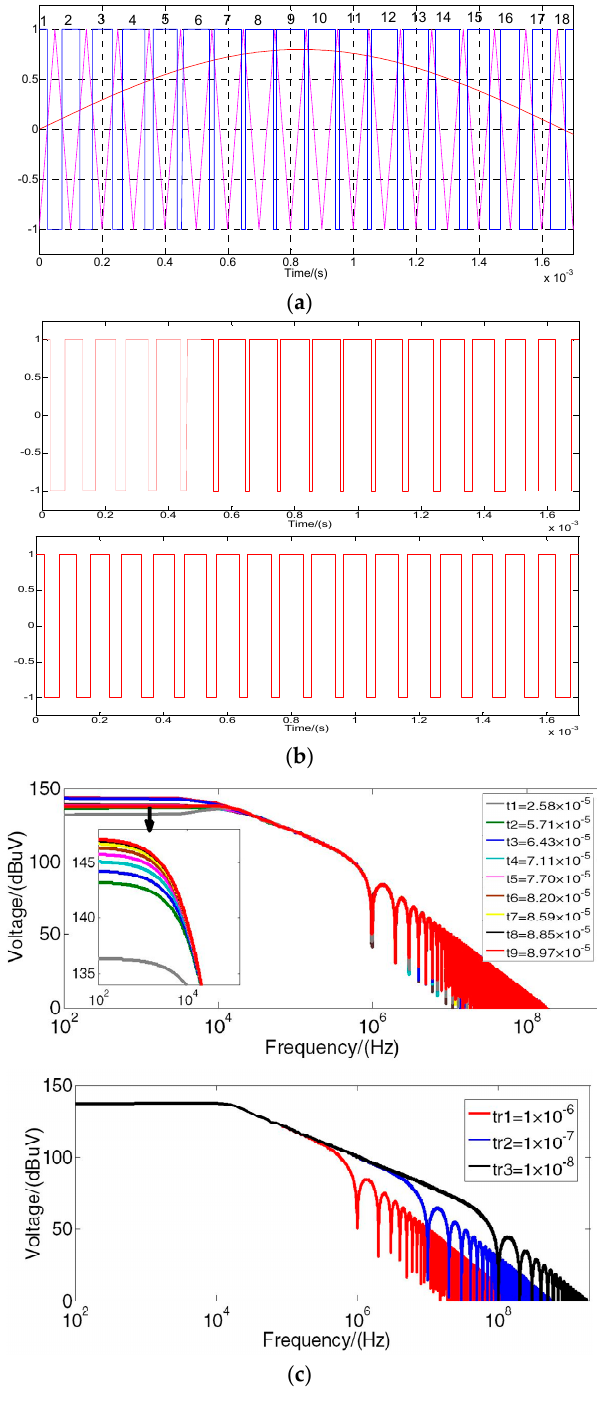
Figure 4. Spectral bounds for a trapezoidal wave: ( a ) SPWM in half-period; ( b ) The effect of pulse-width; ( c ) The effect of rise-time.